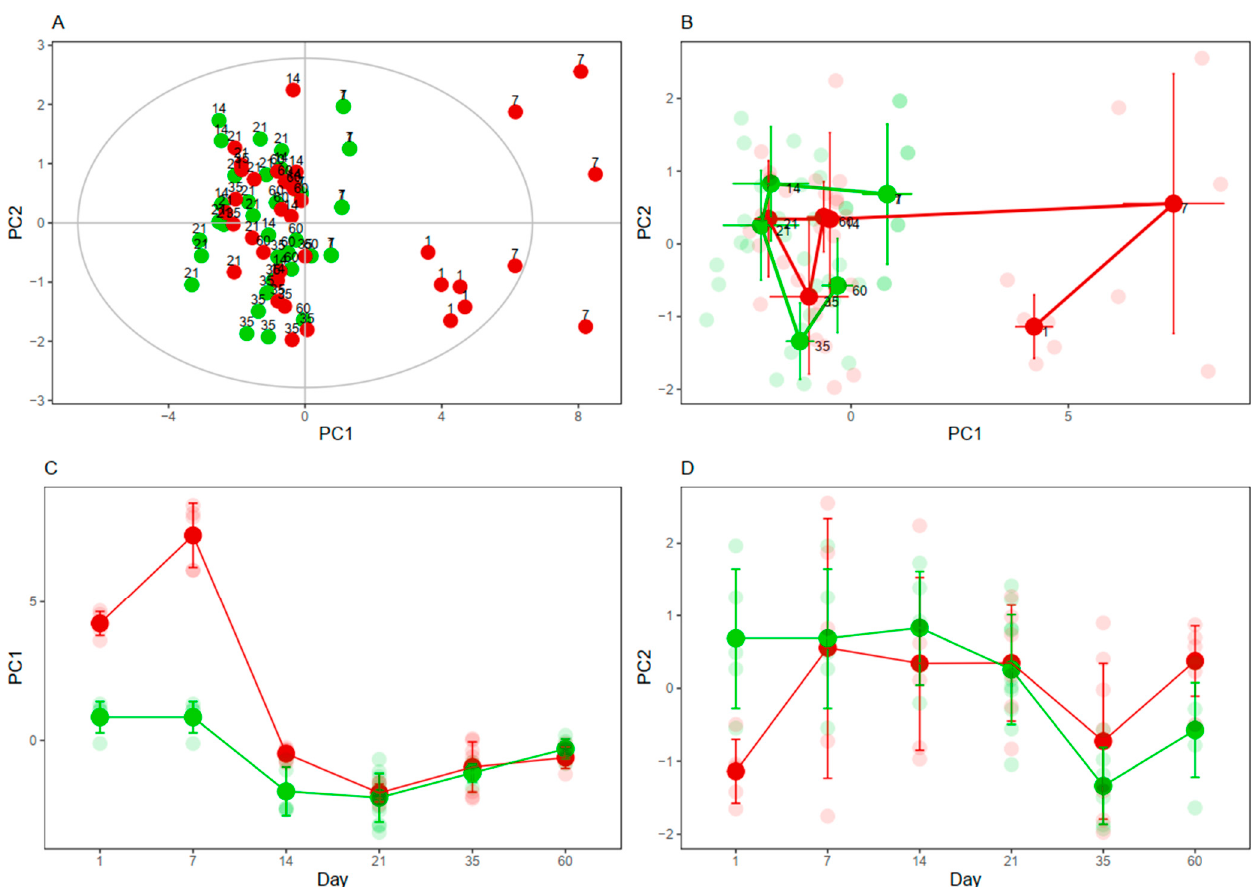
Figure 5. Impact of CIH on cysteine-related thiols . ( A ) Principal Component Analysis performed with the 11 thiol fractions and 74 observations; the first and second components explained 63 and 11% of the variance of the data, respectively. ( B ) Geometric Trajectory Analysis showing PC1 vs. PC2. ( C ) Geometric Trajectory Analysis showing PC1 vs. time. ( D ) Geometric Trajectory Analysis showing PC2 vs. time. Rats submitted to Nx are colored in green and rats submitted to CIH are colored in red. Smaller and lighter dots represent individual rats; bigger and more intense dots represent the average values at Figure 5B–D. Nx7D was used as control for CIH1D and CIH7D. PC: Principal Component.